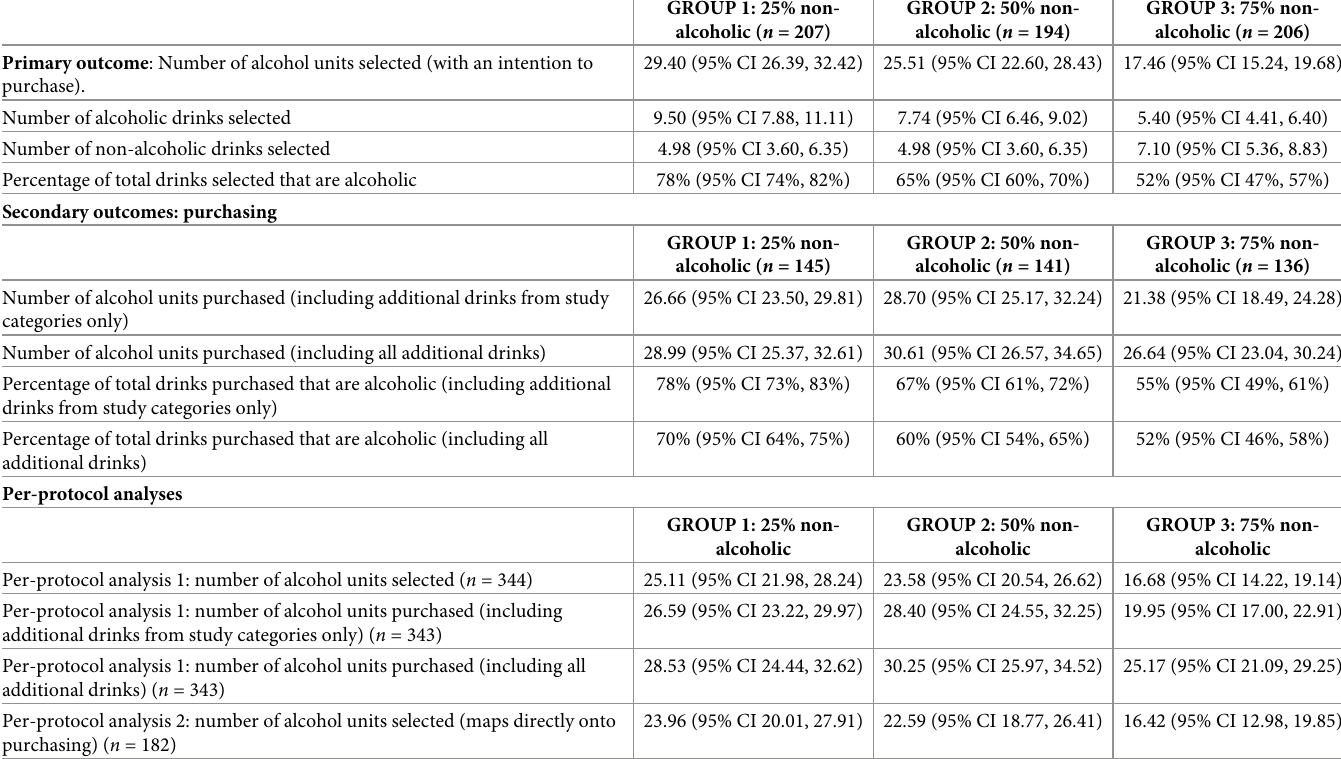
Table 4. Marginal effect estimates predicted from hurdle models (95% confidence intervals) for primary and secondary outcomes.